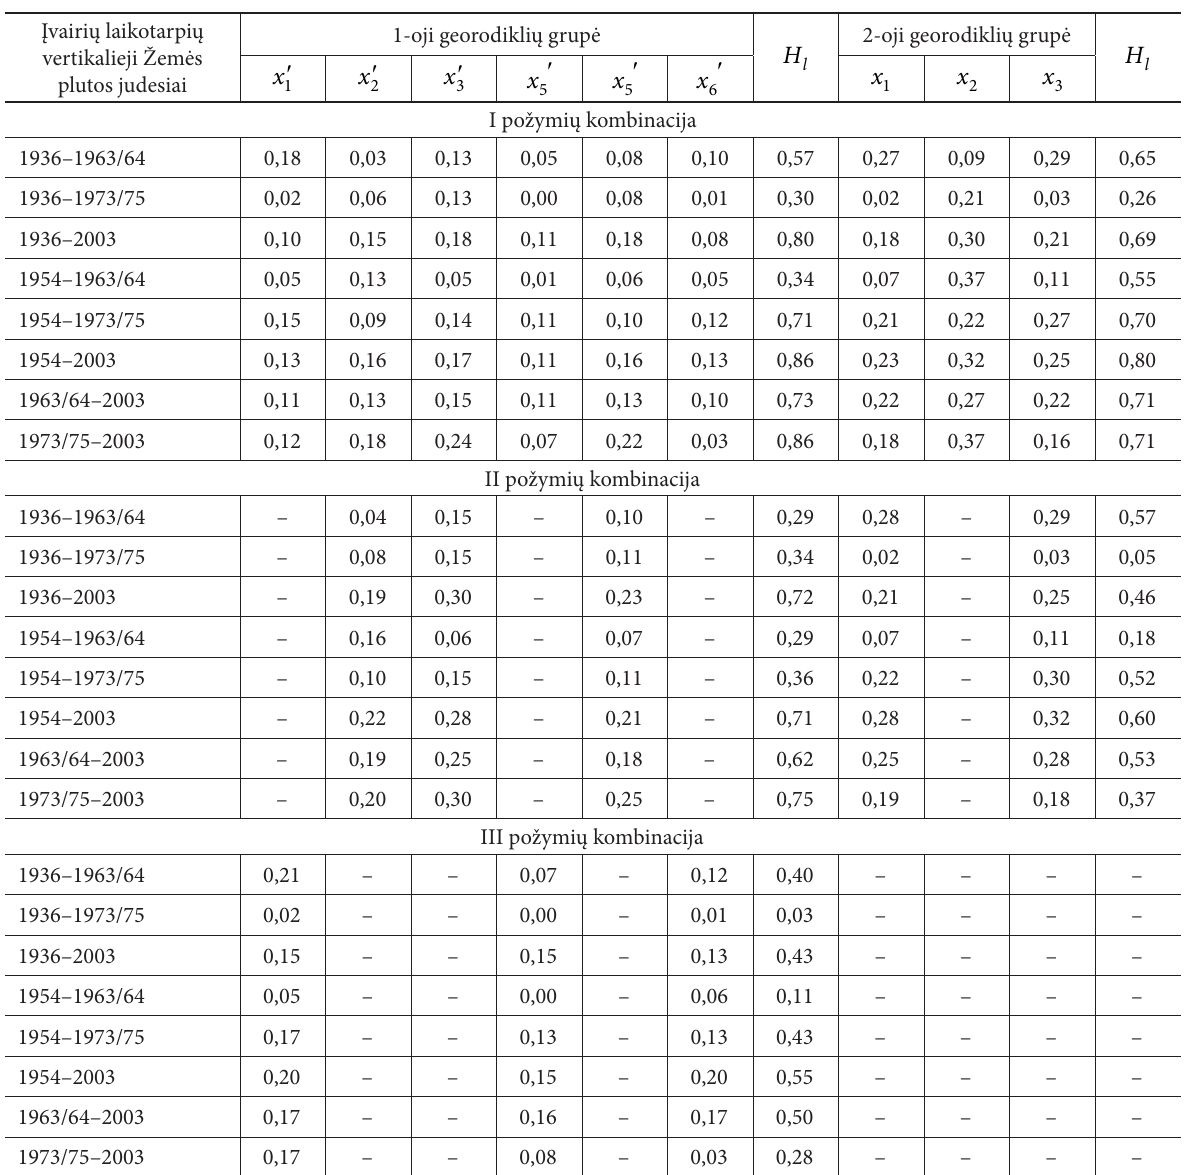
Table 5. Evaluation of the